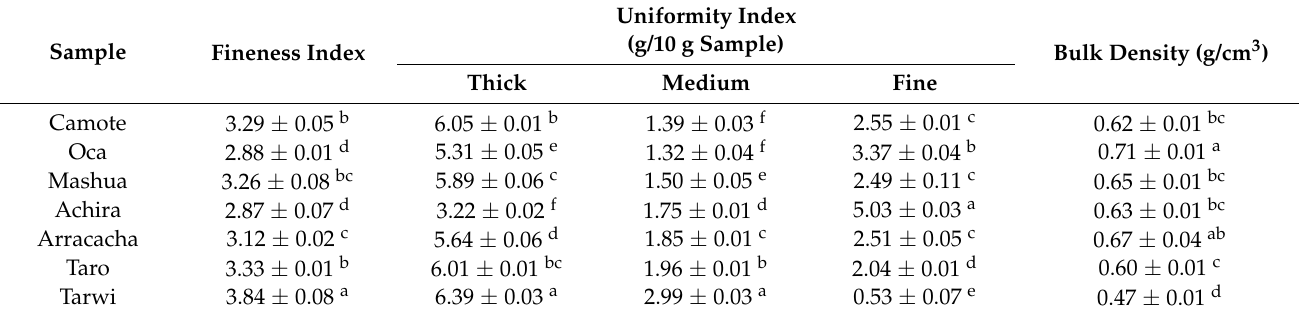
Table 3. Granulometry properties and Bulk density of Andean crops flours.